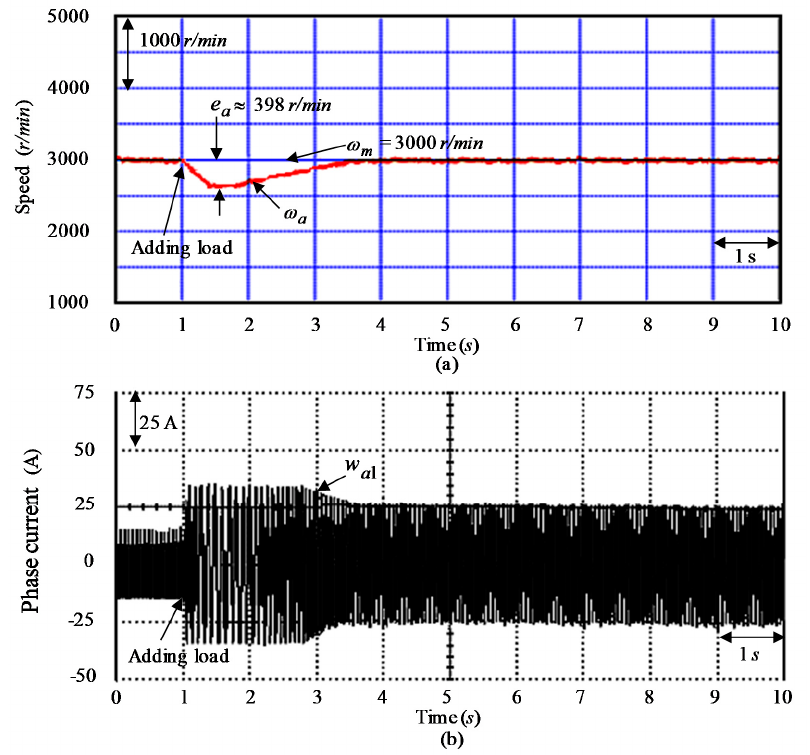
Figure 17. Tested results at the tested Event E3 case by using the controller CT1: ( a ) speed-adjusted response; ( b ) current response in phase a .